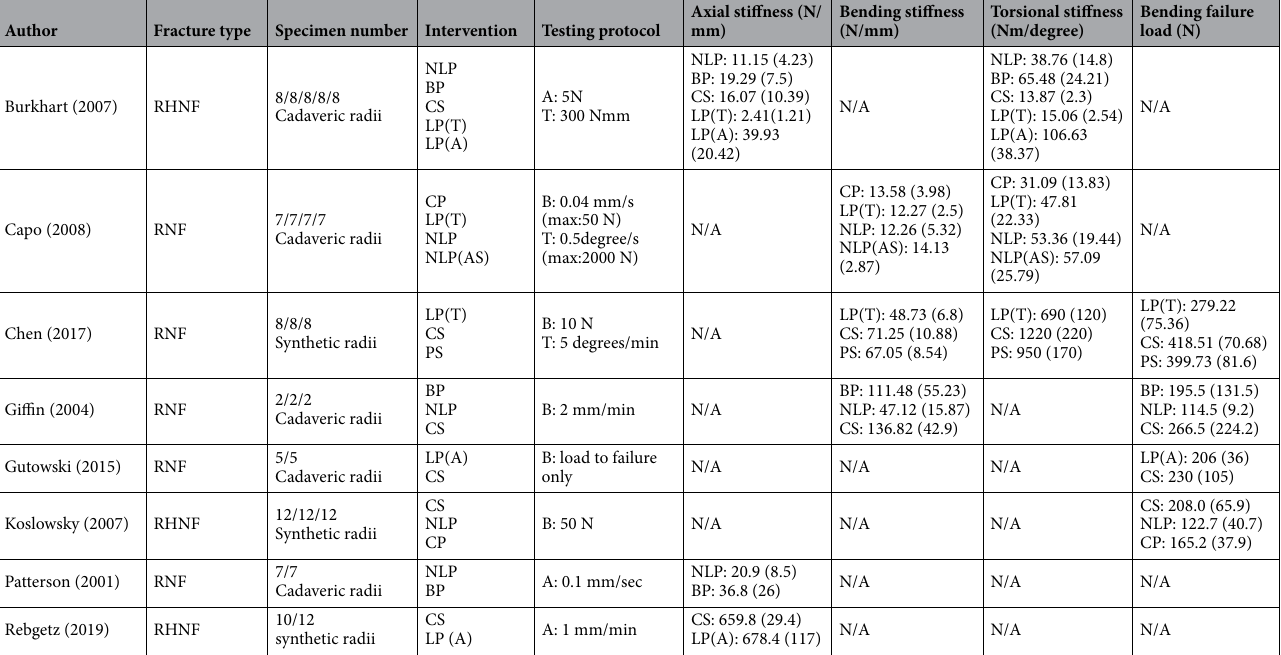
Table 1. Characteristics of the included biomechanical studies. RHNF, Radial head and neck fracture; RNF, Radial neck fracture; CS, Cross screw; LP(T), Locking plate (T plate); LP (A), Locking plate (anatomic plate); NLP, Nonlocking plate; NLP(AS), Nonlocking plate with augmented screw; BP, Blade plate; PS, Parallel screw; CS, Cross pin; A: Axial load; B: Bending load; T: Torsional load. *Data are presented as the mean (standard